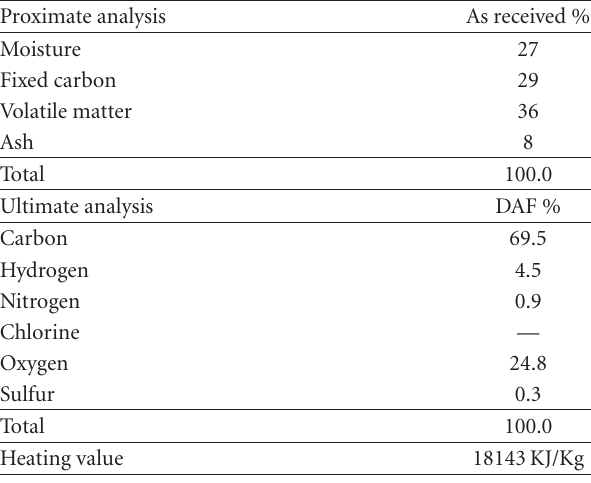
Table 3: Proximate and ultimate analysis of the Usibelli coal [1].